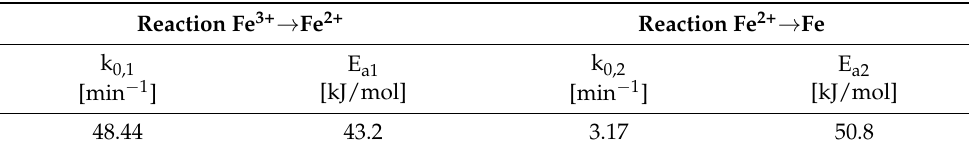
Table 4. Apparent rate constant pre-exponential factors and activation energies according to the isothermal model (Model 1.0).